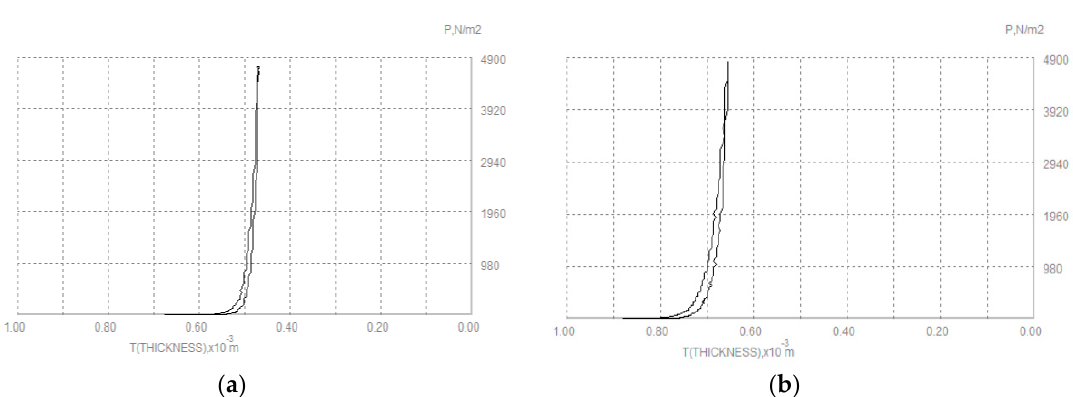
Figure 17. Compression property of ( a ) woollen fabric; ( b ) woollen fabric with interlining.